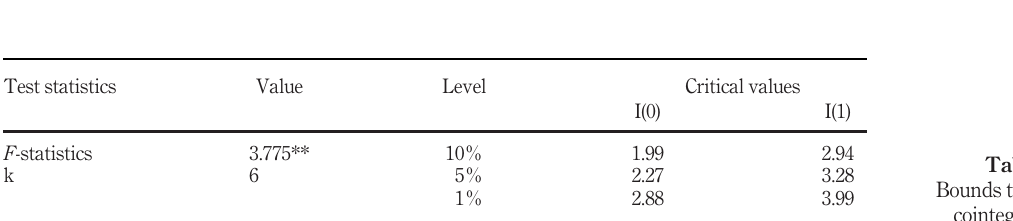
Table 4. Bounds test for